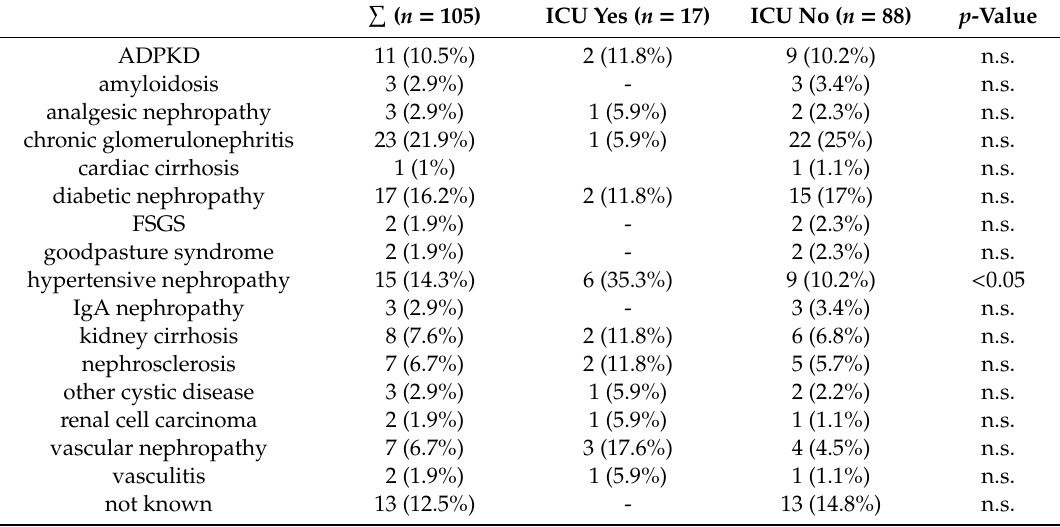
Table A3. Underlying renal diseases for patients with or without ICU stay after